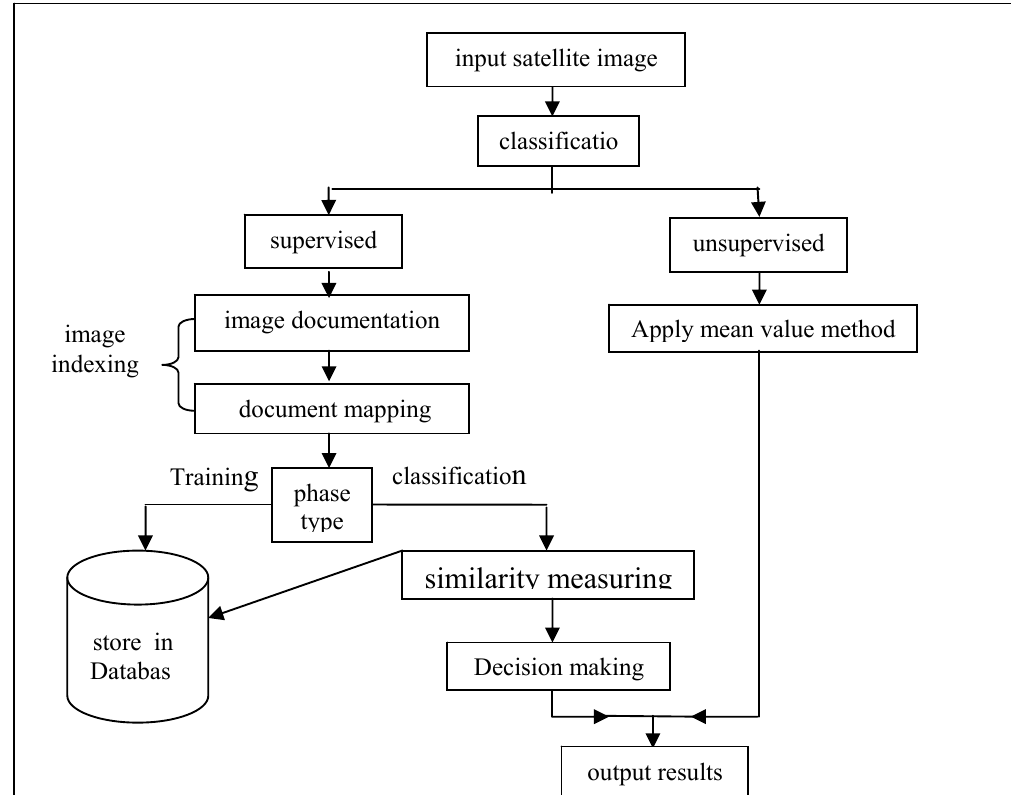
Fig.3: Block diagram of the proposed classification method using MATLAB